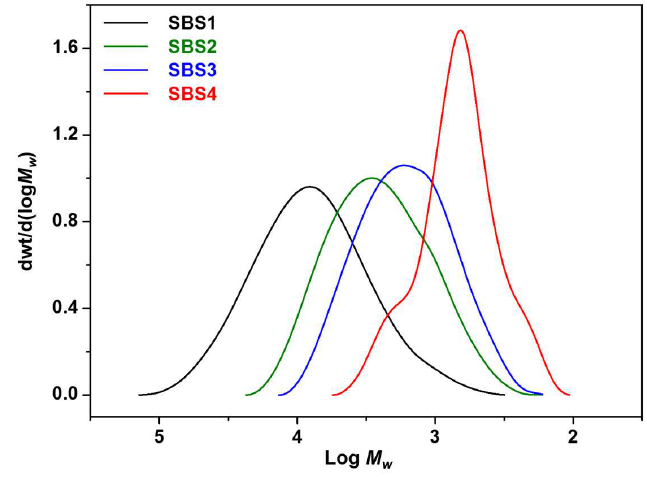
Figure 3. Molecular weight distribution ( MWD ) of biobased HTPB obtained via metathesis degradation from SBS with 10-undecen-1-ol.